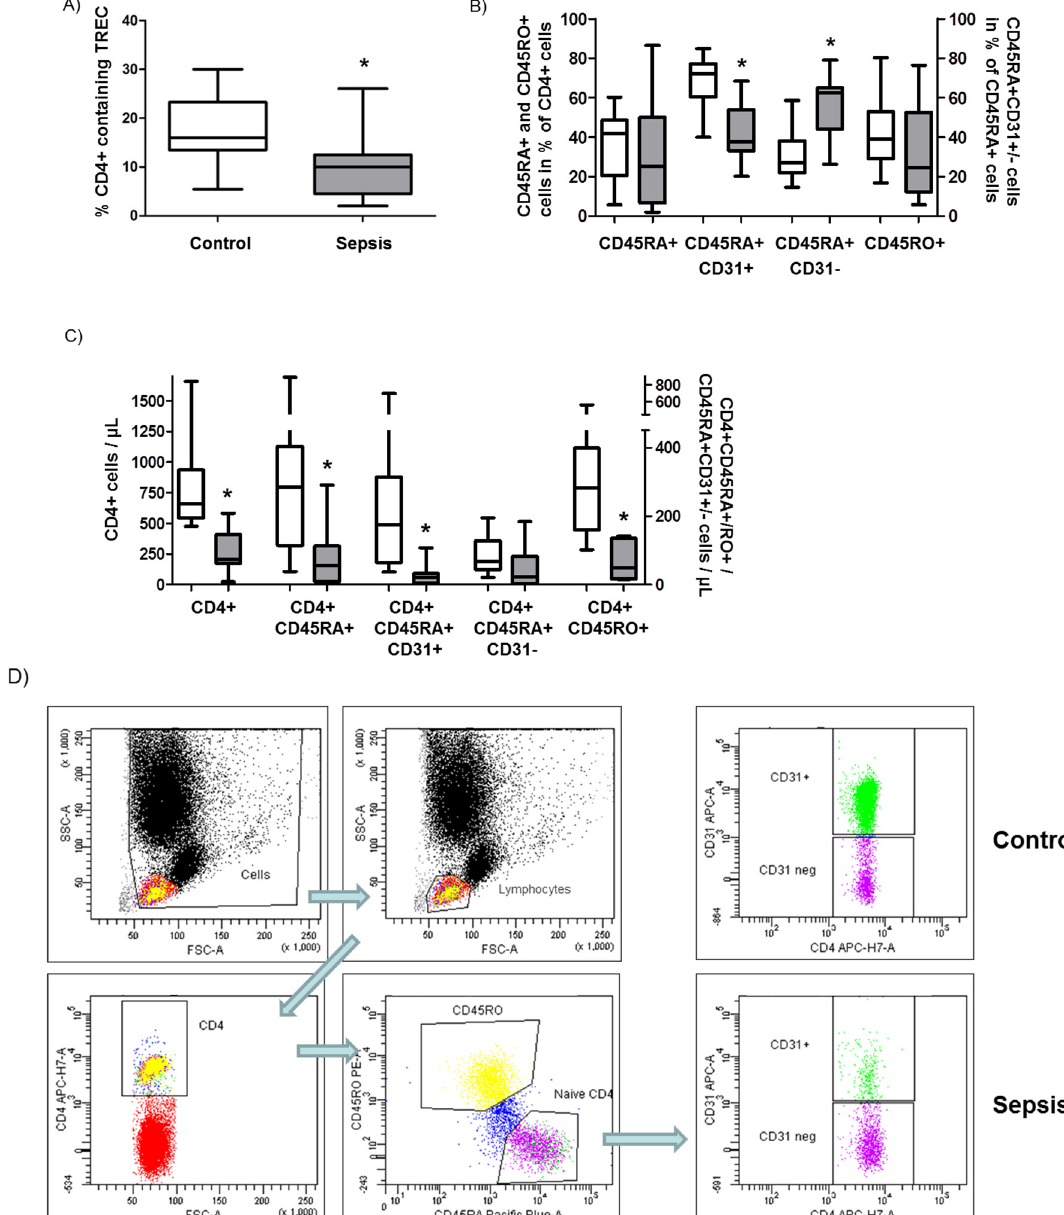
Figure 3. Recent thymic emigrants (RTE) in sepsis patients . ( A ) Determination of the content of TRECs (T-cell receptor excision circle) in CD4+ T cells. ( B ) Assessment of naïve T cells (CD4+CD45RA+), memory T cells (CD4+CD45RO+), RTEs (CD31+CD4+CD45RA+) and peripheral naïve T cells (CD31CD4+CD45RA-) in the blood of sepsis patients and controls (displayed as relative percentage of CD4+ cells). ( C ) Absolute numbers of naïve T cells (CD4+CD45RA+), memory T cells (CD4+CD45RO+), RTEs (CD31+CD4+CD45RA+) and peripheral naïve T cells (CD31CD4+CD45RA-) in the blood of sepsis patients and controls. ( D ) Representative flow cytometry stainings for above-mentioned experiments. Data are displayed as a box-and-whisker plot representing the 25th and 75th percentiles (bottom and top of the box), the median (band inside the box), and the minimum and maximum of all data (ends of the whiskers). Asterisks (*) denote statistical significance, with p < 0.05.